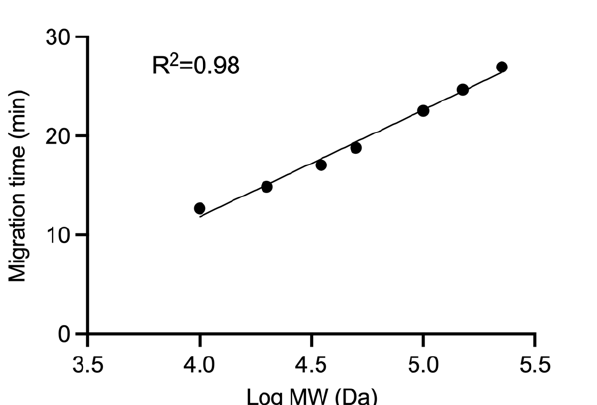
Figure A1. Calibration curve of Migration time (min) vs. log MW (Daltons) for molecular weight marker standard. Table A1. Molecular weight (MW) determination for the different viral proteins of MG1 and rVSV- VSV obtained by extrapolation of migration time from the calibration curve.